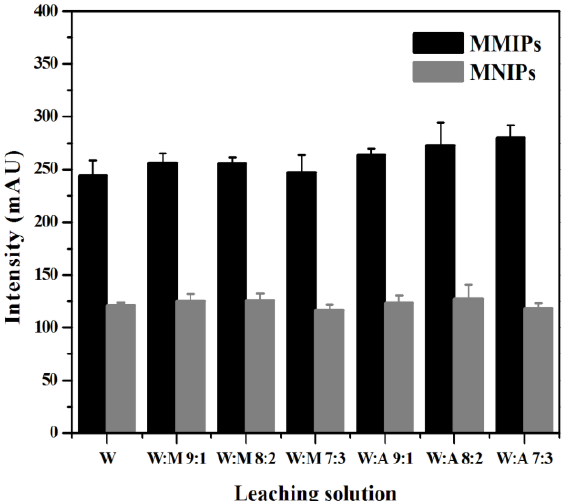
Figure 8. Optimization of conditions affecting the extraction effect of MTX on the MMIPs in regard to the leaching solution.